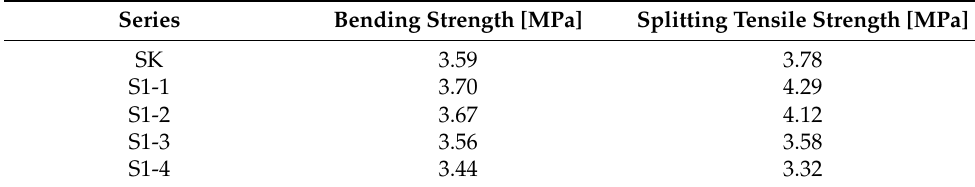
Table 5. Concrete bending tensile strength and splitting tensile